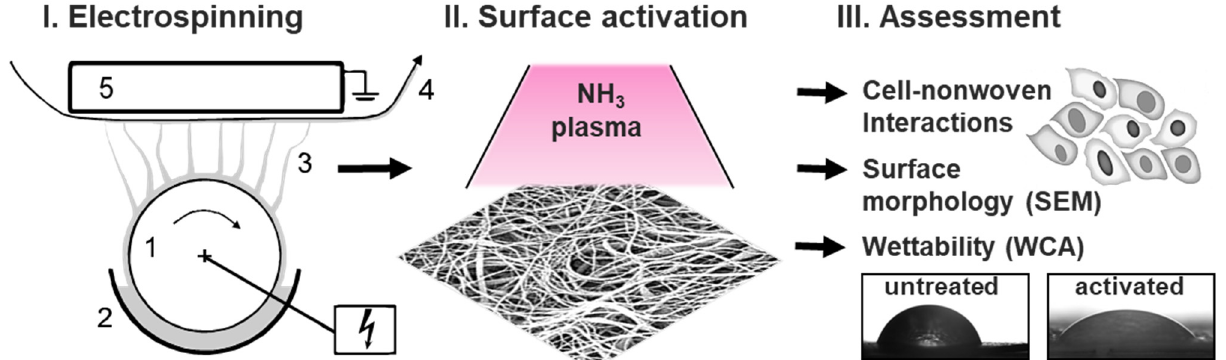
Figure 2. Systematic illustration of the study design and methodological background. ( I ). Preparation of the different used nonwovens using Elmarco nanospider setup, including (1) high-voltage source at the rotating emitter; (2) a bath filled with a polymer solution; (3) fiber formation under solvent evaporation; and (4) a nonwoven collecting unit, (5) which is electrical driven. ( II ). Surface plasma activation of a nonwoven illustrated by a SEM image. ( III ). Characterization of the prepared polymer-based nonwovens via comprehensive biological studies, SEM and contact angle measurements, before and after plasma treatment.